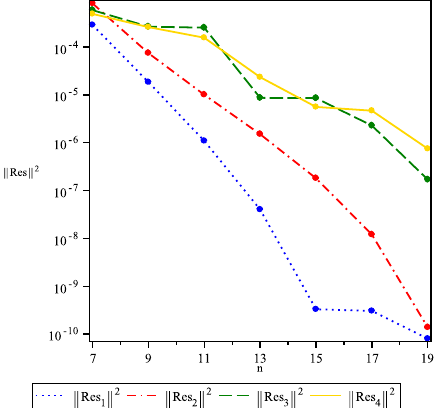
Figure 9. Logarithmic graphs of (cid:107) Res 1 (cid:107) 2 , (cid:107) Res 2 (cid:107) 2 , (cid:107) Res 3 (cid:107) 2 and (cid:107) Res 4 (cid:107) 2 by RGC method when N = 0.8, K = 0.2 and Sc =